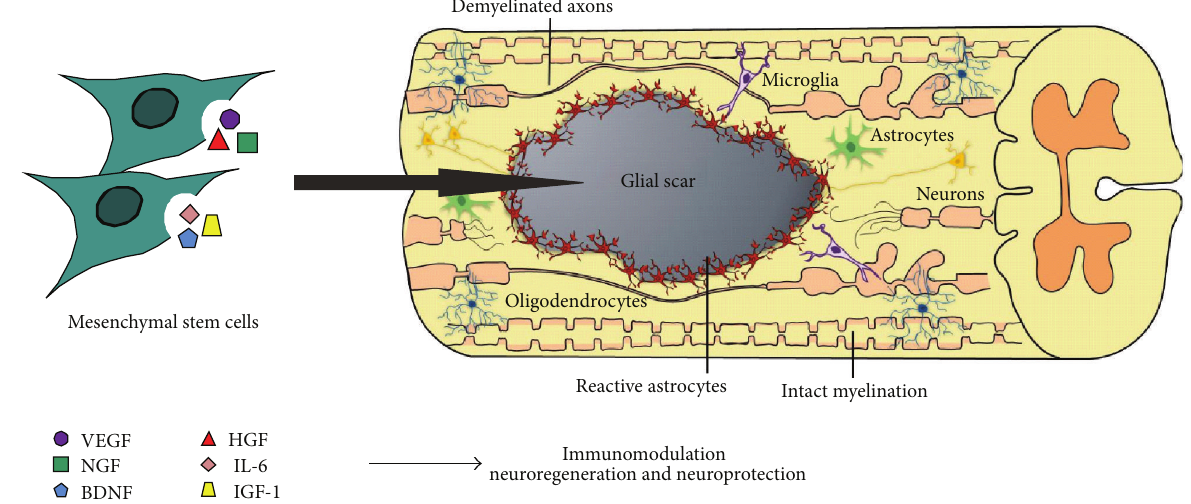
Figure 1: Application of MSCs as a treatment for SCI. The MSCs secretome is believed to be a key player on the promotion of neurore- generation and neuroprotection, as well as the modulation of the inflammatory